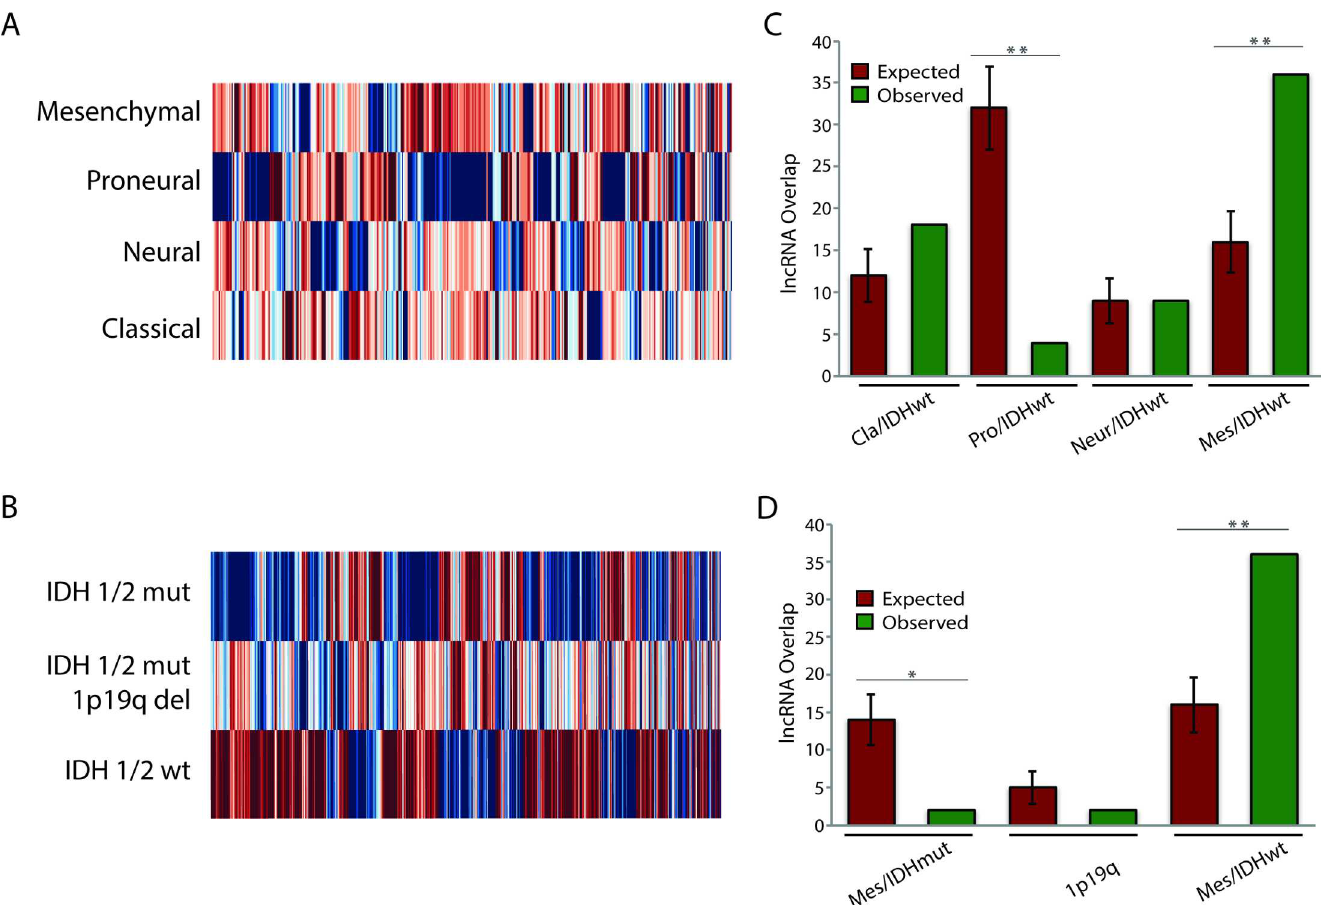
Fig 4. Identification of subtype-associated lncRNAs revealssimilarities between GBM and LGG subtypes. (A) Heatmap of all lncRNAsin GBMs with subtype-specificexpressionpatterns demonstrates large expressiondifferencesbetweenGBM subtypes. (B) Heatmap of all lncRNAs in LGGs with subtype-specific expressionpatterns demonstrates large expressiondifferences betweenLGG subtypes. (C) Overlap of IDH1/2 wt LGG subtype-specific lncRNAswith GBM subtype-specific lncRNAs revealssimilarities betweenmesenchymal GBMs and IDH1/2 wt LGGs. (D) Overlap of GBM mesenchymal subtype-specific lncRNAswith each group of LGG subtype-specific lncRNAs revealssimilarities betweenmesenchymal GBMs and IDH1/2 wt LGGs. * p < 0.00005, ** p < 0.00001. GBM, glioblastoma multiforme; LGG, lower grade glioma; lncRNA, long noncoding